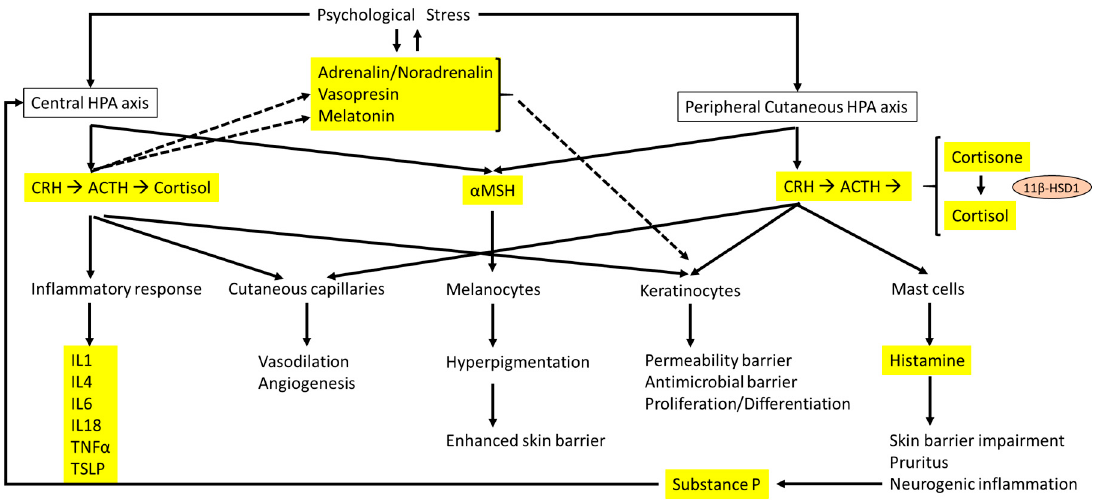
Figure 2. Interactions between the central HPA axis and the cutaneous HPA axis and the effects on the skin barrier and dermatitis. The main hormones, neurotransmitters, and cytokines are highlighted in yellow. Solid arrows represent direct effect of hormones and neurotransmitters related to the HPA axis, whereas dashed lines indicate the influence of psychological stress on other hormones and neurotransmitters that are different from the HPA axis and linked to epidermal homeostasis.